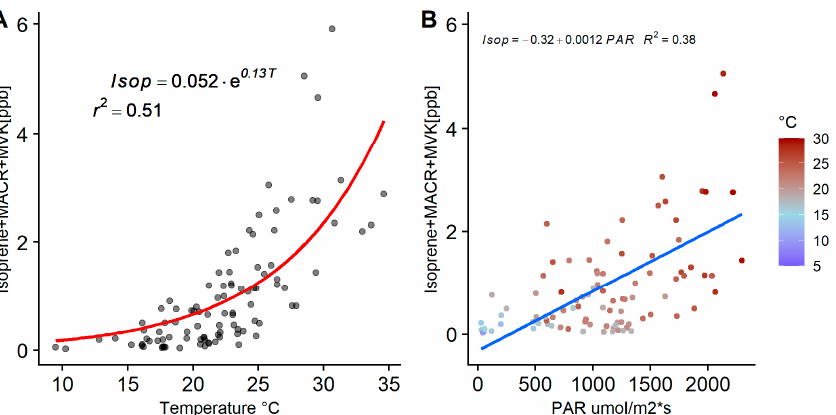
Figure 9. ( A ) Composite mean concentration of monoterpenes and isoprene grouped by hour be- tween February and May. On the right y-axis is the average temperature for the analysed period. June data were excluded to capture a better representation of the influence of temperature on VOC concentrations. The black line represents the median, the line on the box is the 95% of the distribu- tion range and outliers are shown as blue and pink. The calculated PAR from the solar radiation observations has a correlation coefficient with temperature of 0.62, and both parameters follow a similar daily pattern influencing the VOC emissions (see Supplementary Figure S8). ( B ) Percent- age contribution of BVOC groups to total BVOC loading per hour using mean concentrations.